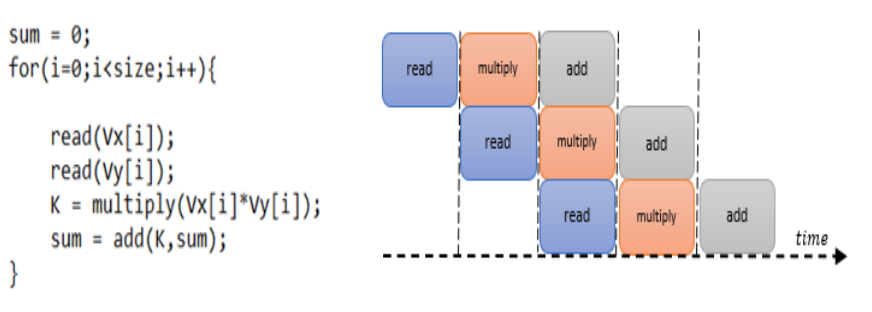
Figure 7. Pipeline directive applied on vector multiplication.